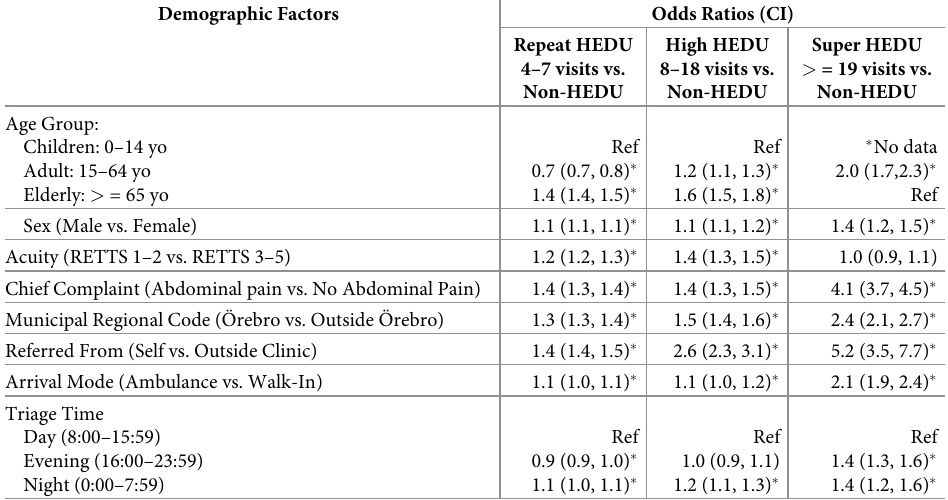
Table 3. Associations between demographic factors and HEDU visit type. Demographic Factors Odds Ratios (CI)